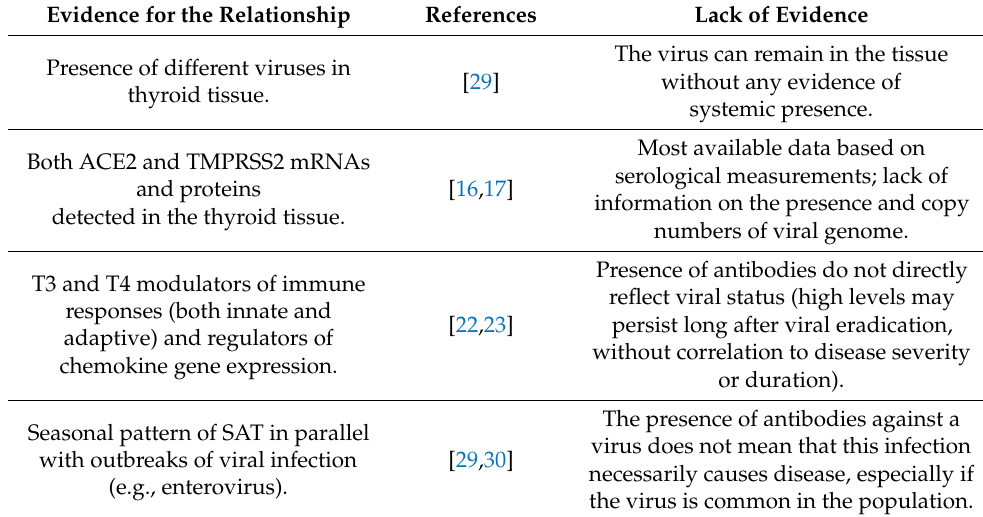
Table 2. Main elements that support and weaken the relationship between viral infection and thyroid